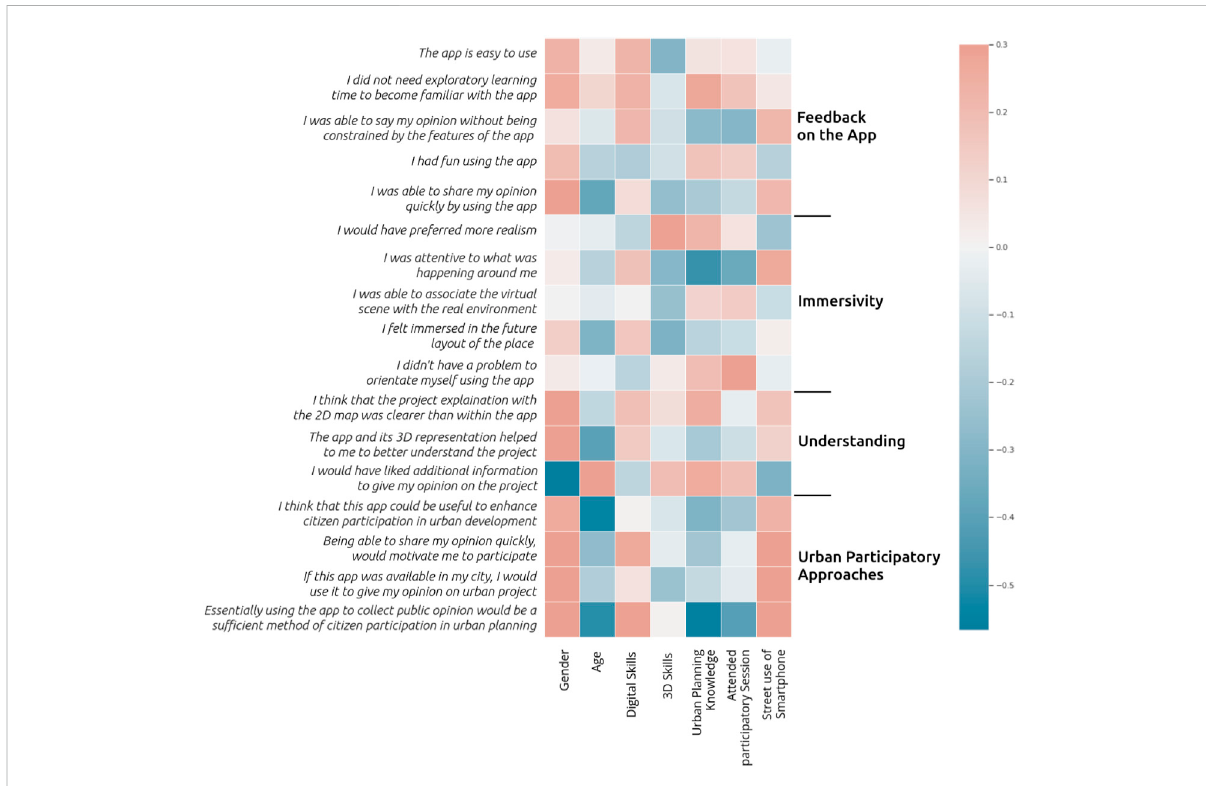
FIGURE 8 Correlation matrix between socio-demographic characteristics of the participants and their answers in the